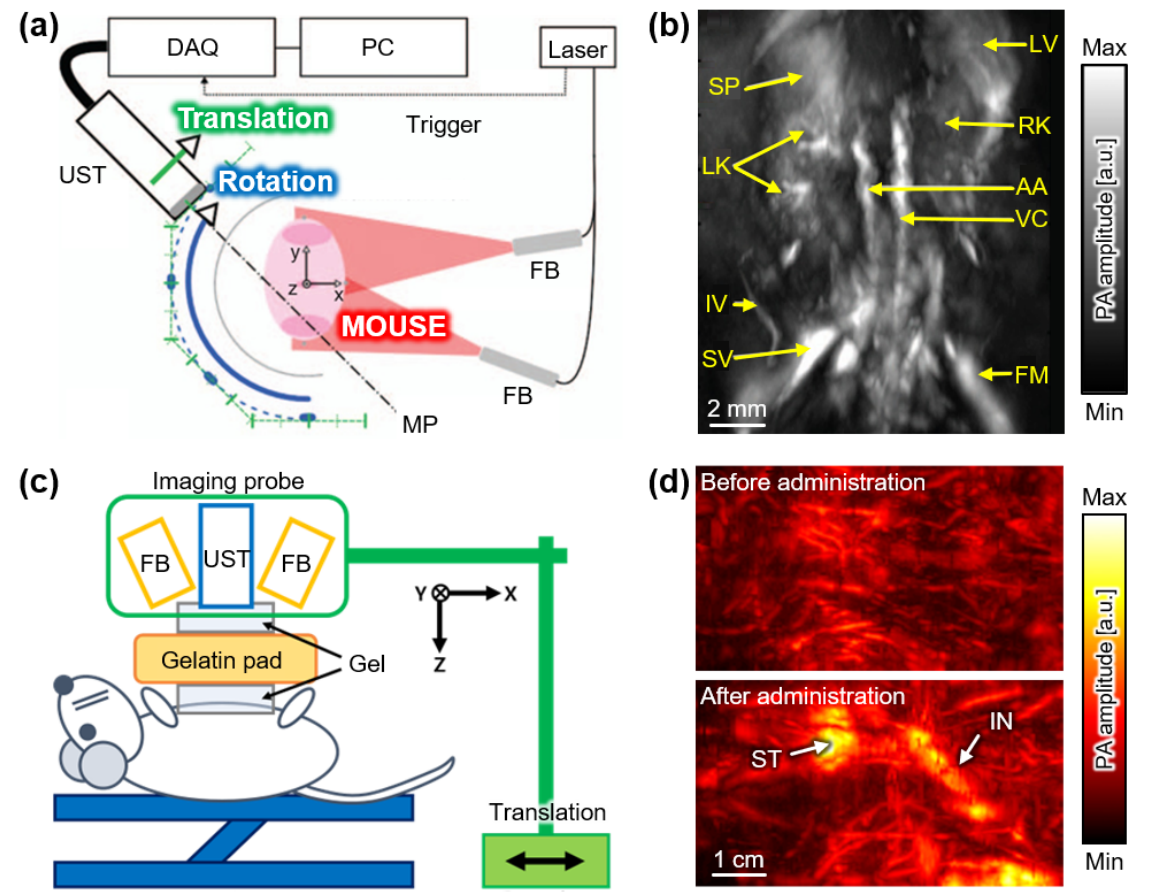
Figure 2. PAI systems with linear array USTs. ( a ) Schematic of PAI system with a combination of translational and rotational scans using a linear array UST. ( b ) Representative PA image of abdomen area of a mouse in vivo. ( c ) Schematic of PAI system with a simple translational scan using a linear array UST. ( d ) PA images of abdomen area of a rat in vivo before and after oral administration of exogenous contrast agents. PA, photoacoustic; PAI, photoacoustic imaging; UST, ultrasound transducer; FB, fiber bundle; DAQ, data acquisition module; SP, spleen; LV, liver; LK, left kidney; RK, right kidney; AA, abdominal aorta; VC, vena cava; IV, ischiatic vein; SV, saphenous vein; FM, femur; ST, stomach; IN, intestine. The images are reproduced with permission from refs. [33,39].